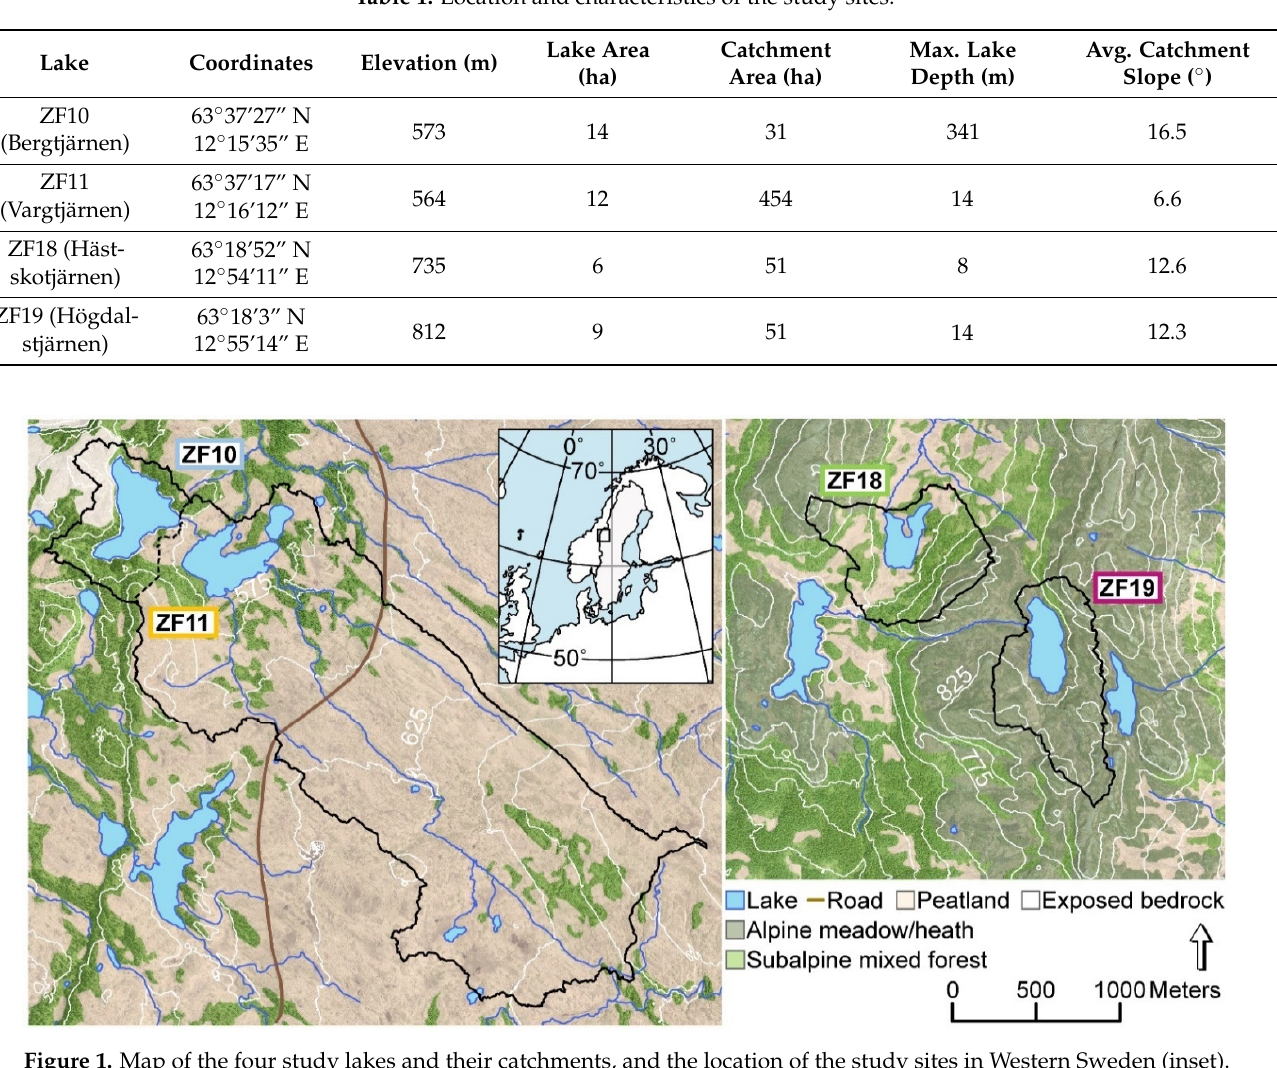
Figure 1. Map of the four study lakes and their catchments, and the location of the study sites in Western Sweden (inset). Black lines delineate the catchment boundaries. ZF10: Bergtjärnen, ZF11: Vargtjärnen, ZF18: Hästskotjärnen and ZF19: Högdalstjärnen.